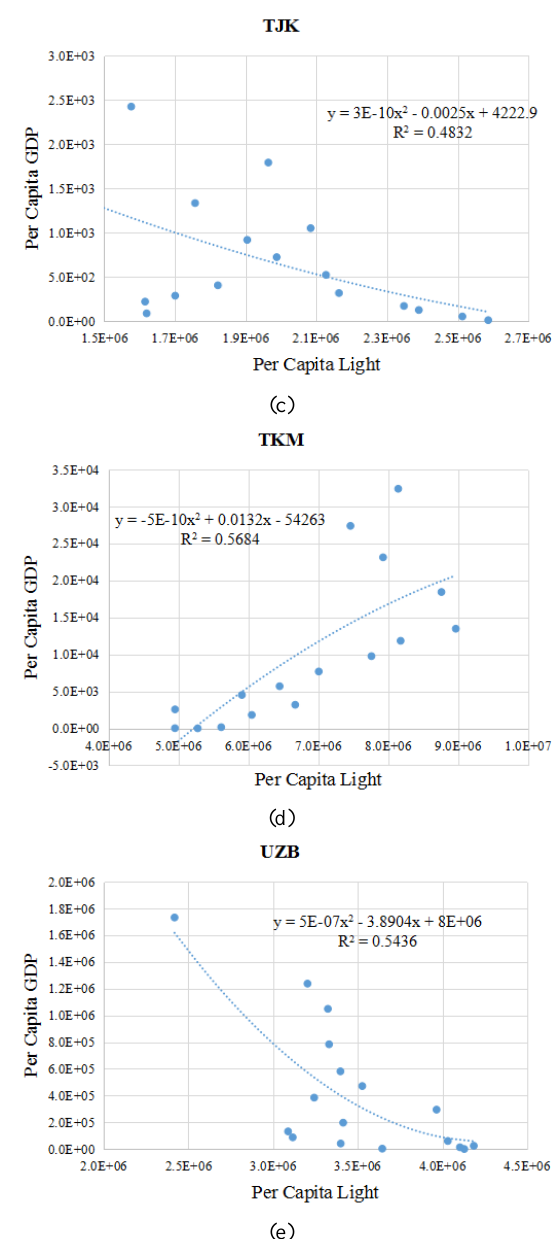
Figure 10. The best-fit regression results of per capita GDP and per capita lighting for five counties (a) Kazakhstan, (b) Kyrgyzstan, (c) Tajikistan, (d) Turkmenistan, (e)